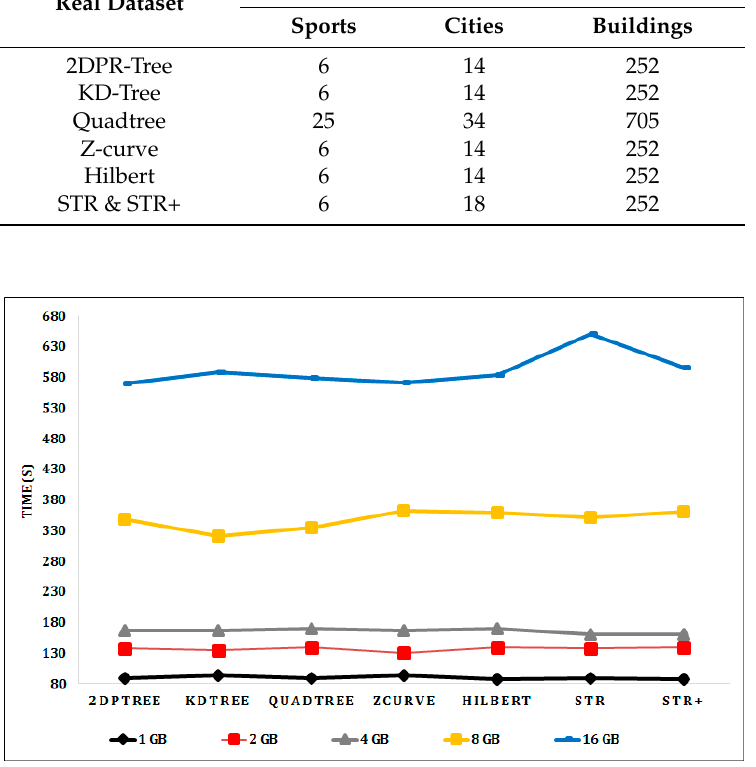
Figure 5. Indexing time for the synthetic datasets.